Question: What kind of plot is shown here?
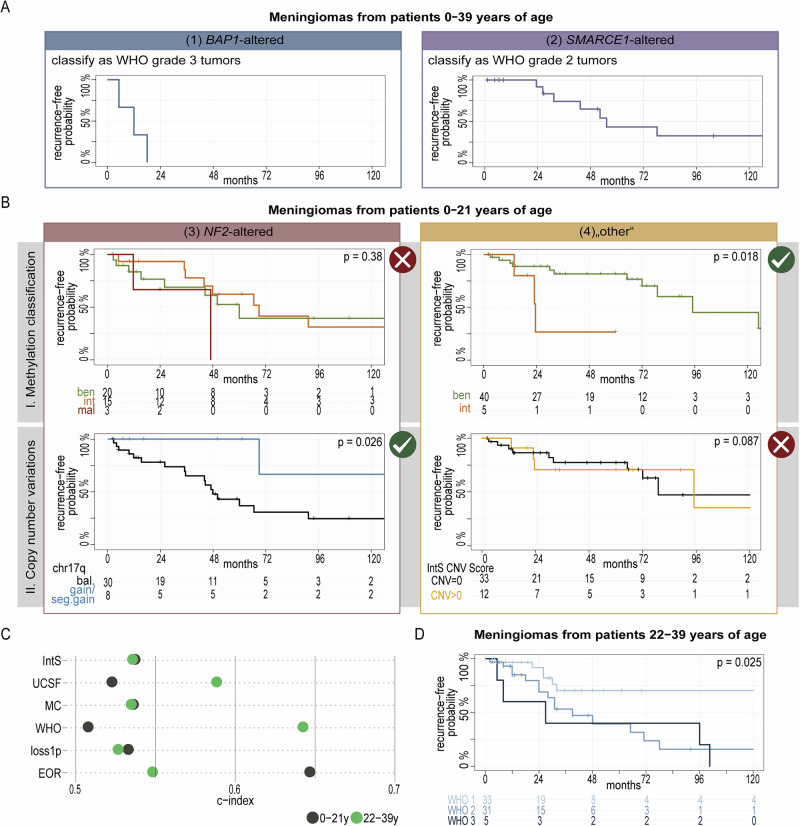
Answer: survival